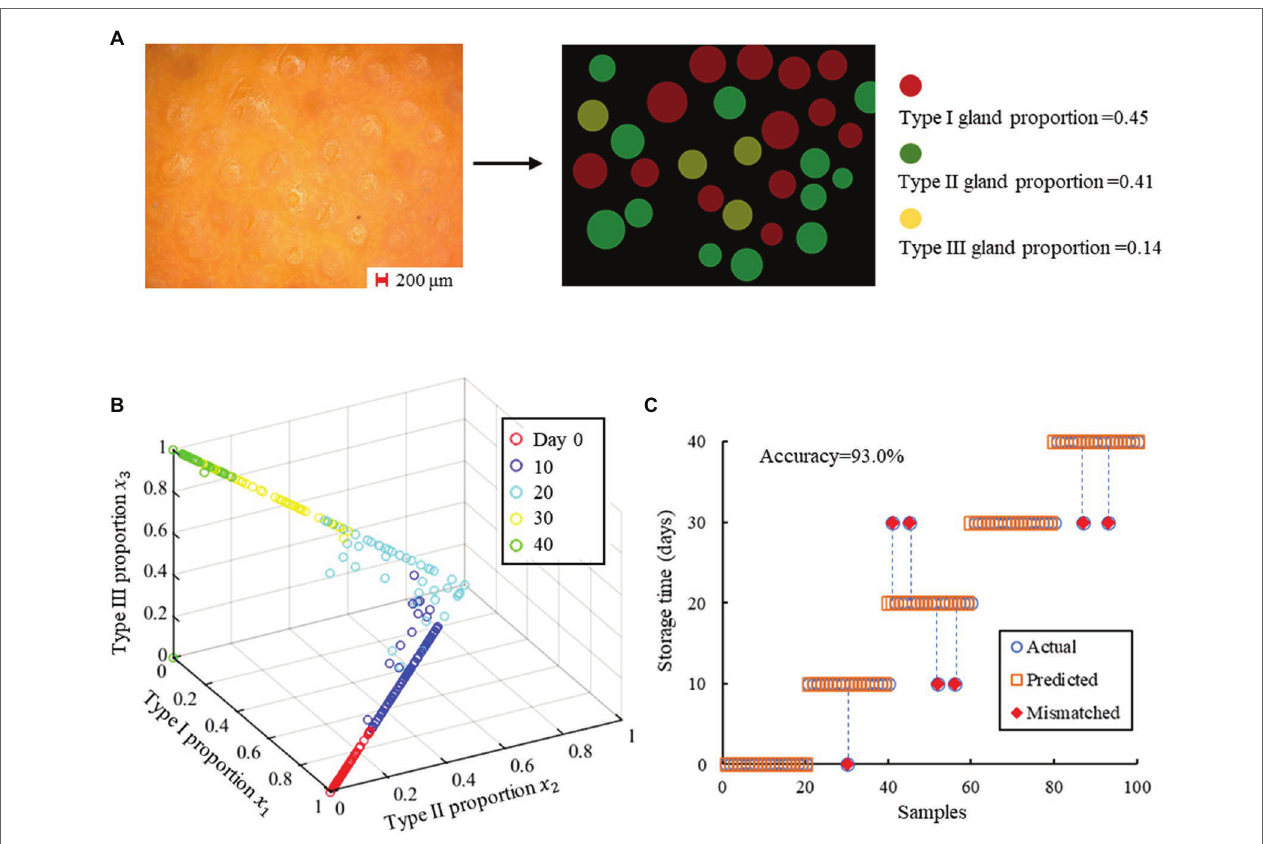
FIGURE 5 | The results of the KNN-based prediction model. (A) The procedure to obtain the proportions of different glands from an image. (B) The training set of the KNN-based prediction model, in which the proportions of three types of oil glands in each picture are the features to perform freshness prediction. (C) Comparison between the predicted and actual storage time.